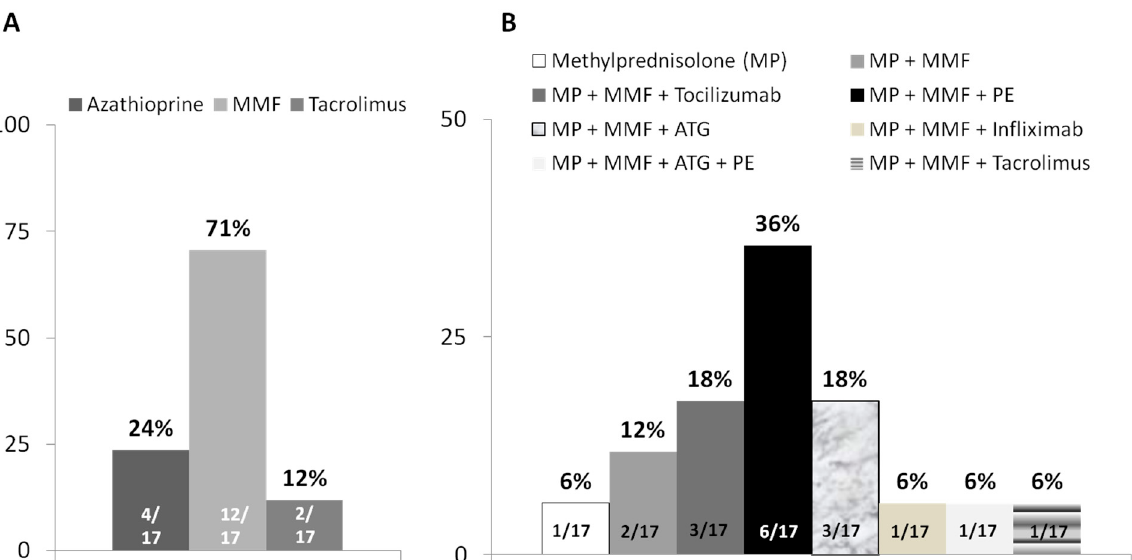
Figure 1. Treatment Preferences. ( A ) Preferred drugs in second-line therapy for immune-mediated hepatitis refractory to treatment with corticosteroids. ( B ) Treatments of choice for acute liver injury (defined by increased bilirubin level plus INR > 1.5) owing to immune-mediated hepatitis associated with treatment with ICIs. ATG, anti - thymocyte globulin; MMF, Mycophenolate mofetil; MP, methyl-prednisolone; PE, plasma exchange.